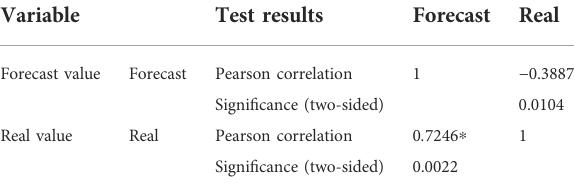
TABLE 5 Correlation coef fi cient test